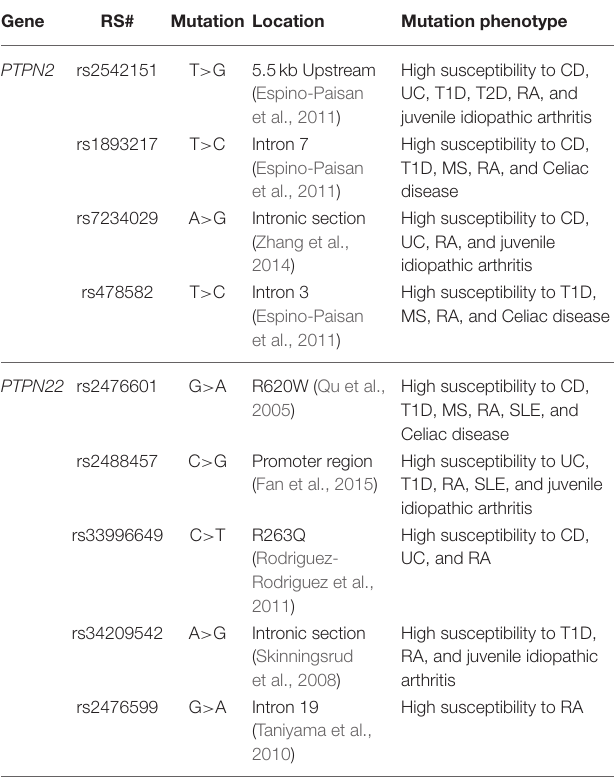
TABLE 2 | List of SNPs in PTPN2/22 examined in this study.